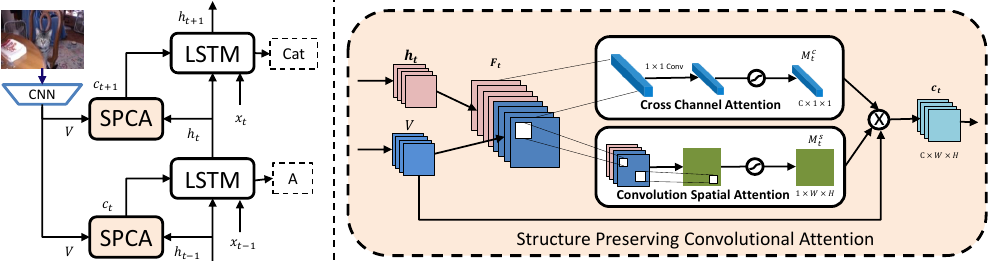
Figure 2. The left side is an illustration of the proposed attention module. The right side is a diagram of our Structure Preserving Convolutional Attention